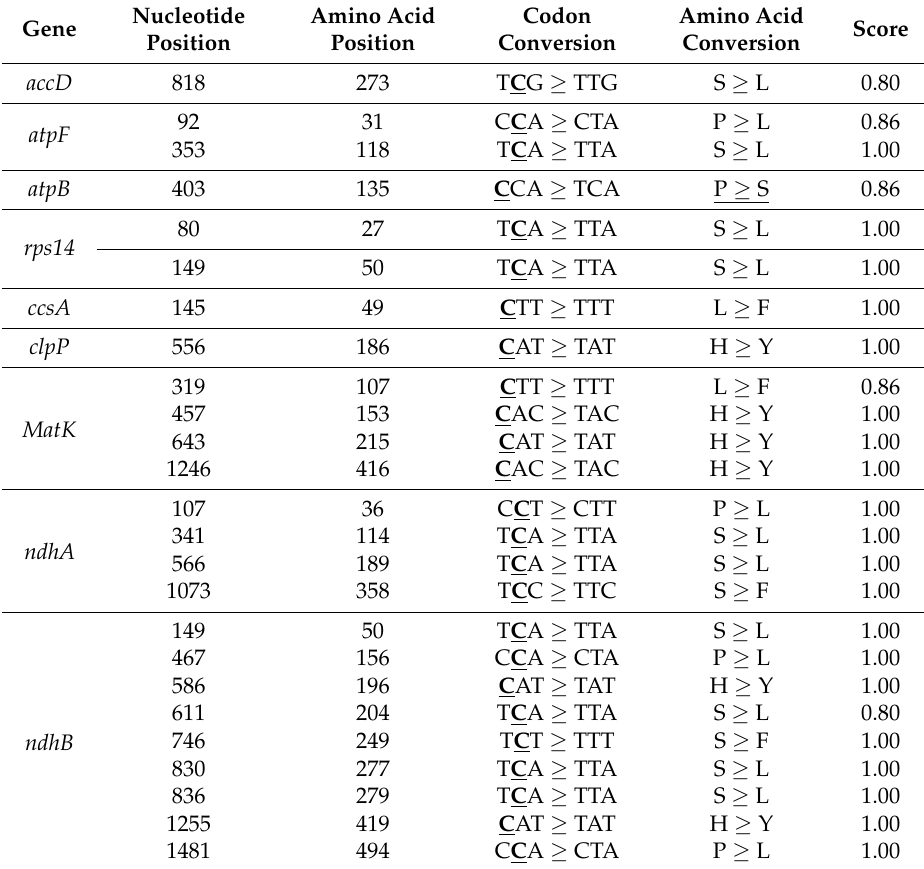
Table 2. Predicted RNA editing site in the A. altissima chloroplast genome.